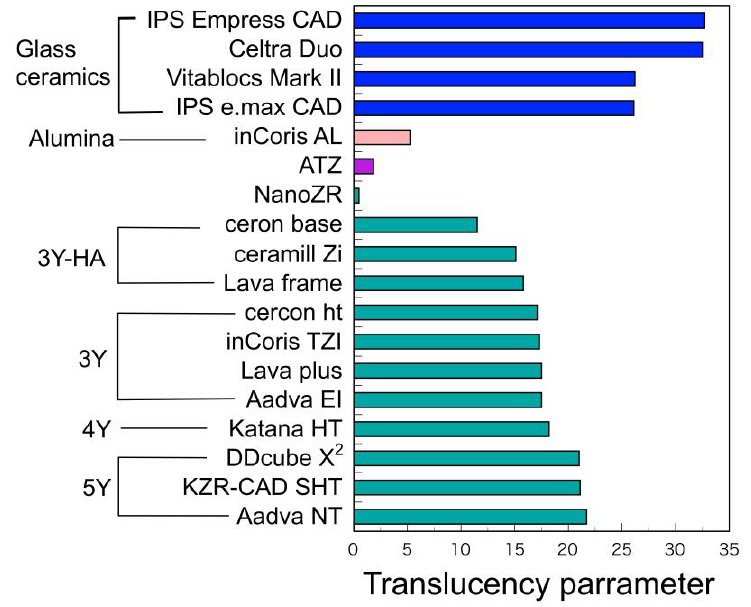
Figure 8. Translucency parameter of CAD/CAM materials. Adopted from manufacturers indication.